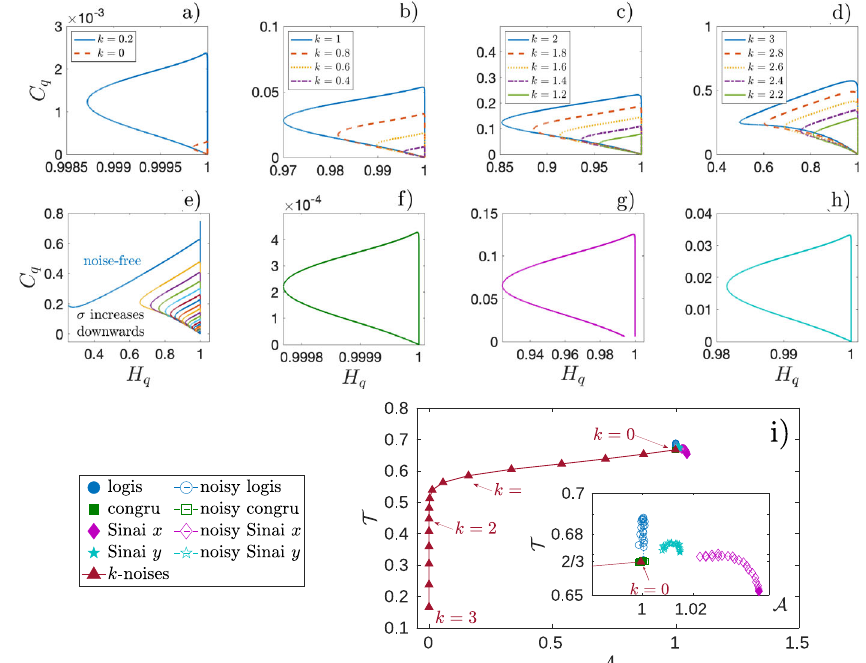
Fig. 7 q -parametrisation of the complexity – entropy plane and Tarnopolski plane. Entropy-complexity plane with q ∈ [10 − 4 , 1] ∪ [1, 10 3 ] with steps 10 − 3 and 10 − 2 , respectively, for k -noises with a k = 0 and 0.2, b k = 0.4, 0.6, 0.8 and 1, c k = 1.2, 1.4, 1.6, 1.8 and 2, d k = 2.2, 2.4, 2.6, 2.8 and 3, e logistic map with additive noise with σ ∈ [0, 1] with step 0.05, f linear congruential map, g x and h y coordinate of the Sinai map. i Turning point probability T versus the Abbe number A for k -noises ( k ∈ [0, 3] with step 0.2) and chaotic maps with additive noise with σ ∈ [0, 1] with step 0.05. Inset plot shows zoom near the stochastic zone ( T ¼ 2 = 3 end A ¼ 1). Noise-free sequences (solid symbols). Noisy sequences (open symbols). k : correlation degree and σ : intensity of the noise contamination.